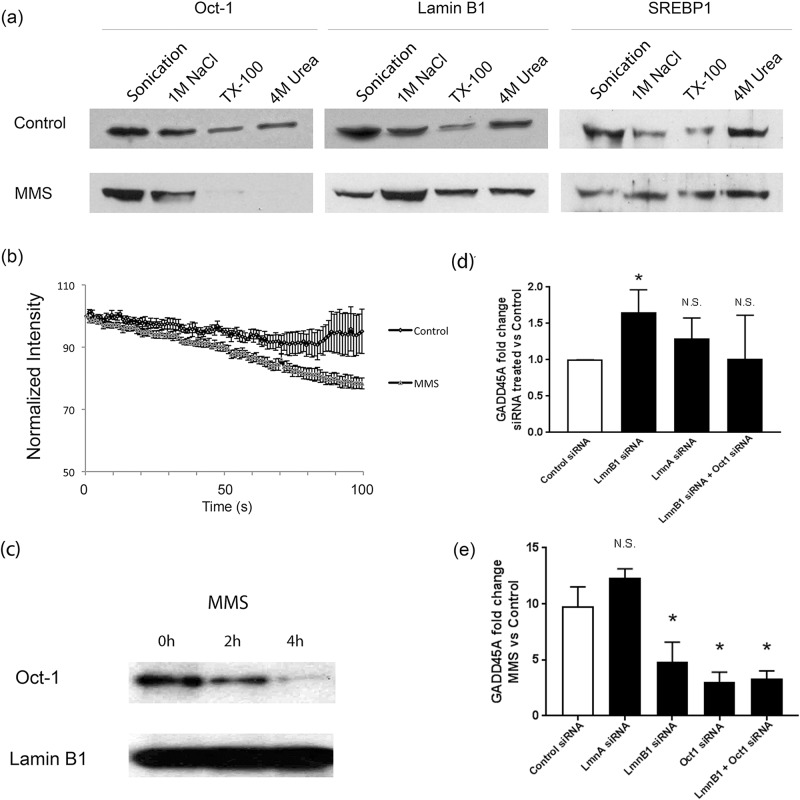
Oct-1 interaction with the nuclear lamina is dynamic.(a) Sequential nuclear extraction of Oct-1, lamin B1 and SREBP1 from control HeLa cells and cells treated with MMS. Oct-1 extractability is increased following MMS treatment showing reduced association within the nucleus following this treatment. (b). FLIP analysis of GFP-Oct-1 stability at the nuclear envelope: Normalised intensity measurements of regions of interest containing the peripheral GFP-Oct1 signal were used to assess fluorescence loss in photobleaching for control HeLa cells, or cells treated with MMS. The more rapid loss of GFP = Oct1 after MMS treatment confirms a weakened interaction with the nuclear periphery. (c) Co-immunoprecipitation of Oct1 with lamin B1: Control and MMS-treated HeLa cells were subject to immunoprecipitation using an anti-lamin B1 antibody. IP samples were then analysed using anti-lamin B1 and anti-Oct-1 antibodies. This shows a progressive loss of a direct interaction between lamin B1 and Oct1 following MMS treatment. (d) Expression of an Oct1 target gene is increased when lamin B1 expression is reduced: GADD45A expression was assessed using qPCR in HeLa cells transfected with control siRNA or siRNA directed against lamin A, lamin B1 or lamin B1 and Oct-1 together. Only lamin B1 siRNA transfection had a significant effect on GADD45A expression. (e) Stress mediated increase in an Oct1 target gene expression requires lamin B1 and Oct1: GADD45A expression was assessed in HeLa cells transfected with siRNA directed against lamin A, lamin B1, Oct-1 or lamin B1 and Oct-1 together, comparing MMS treatment with control. Transfection with the latter three combinations reduces the response to MMS treatment indicating the involvement of both lamin B1 and Oct-1 in the control of GADD45A expression following MMS treatment.